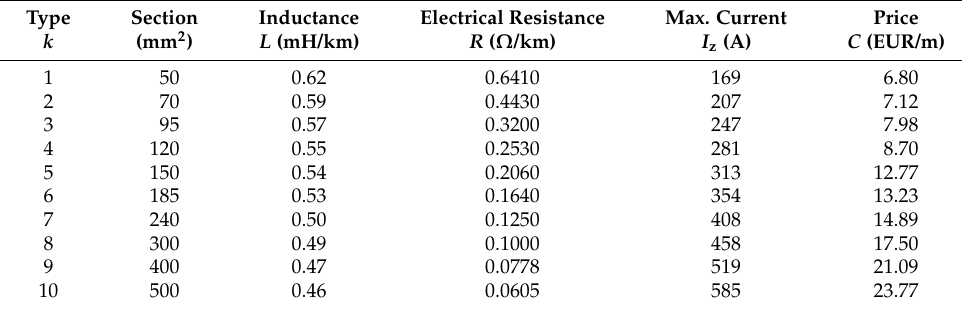
Table 1. Unipolar cable characteristics (LXHIOV) 18/30